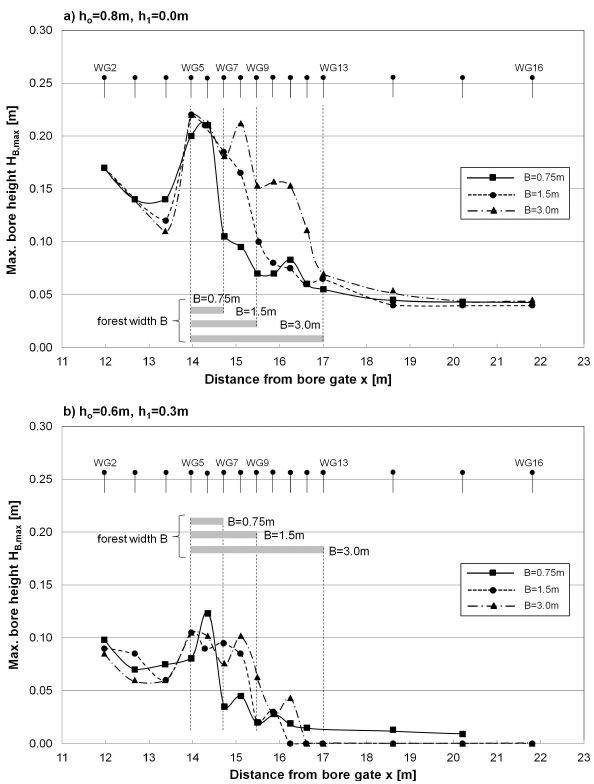
Fig. 11. Exemplary envelope of forces exerted by solitary waves on single mangrove tree models: (a) in case of forest width B = 3.0m and water depth h = 0.465m, (b) in case of forest width B = 1.5m and water depth h = 0.465m (see Fig. 6 and Table 3 for force trans- ducer